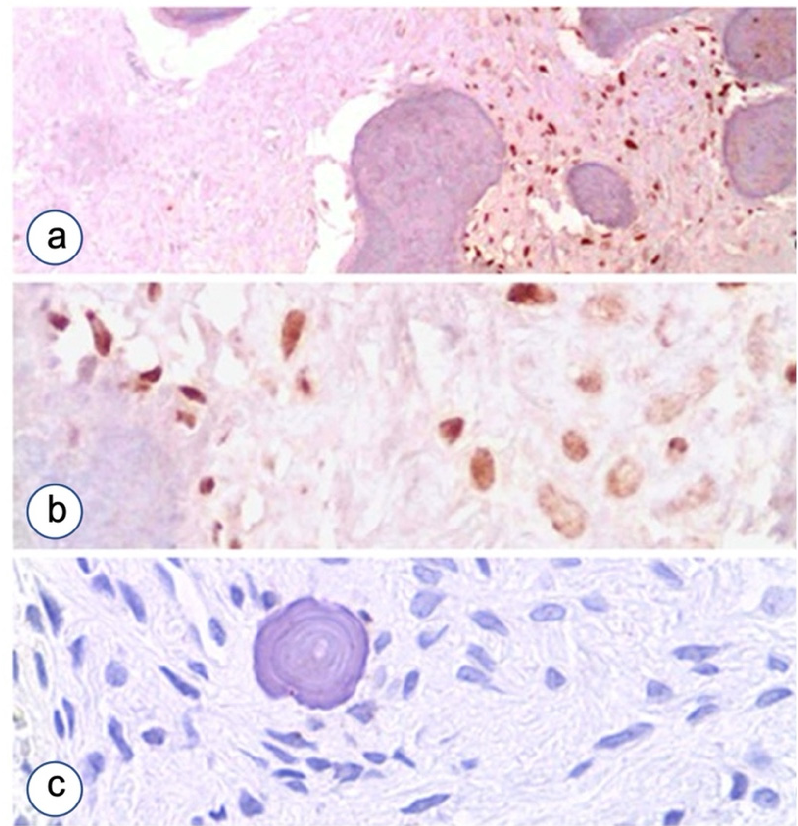
Figure 2. Cytokeratin cocktail in HPT-JT syndrome and fibrous dysplasia. CKAE1/AE3 is expressed in maxillary tumor associated with HPT-JT syndrome. ( a ), Further magnification in ( b ), but it stains negative in FD even in cases with high cellularity. ( c ) LSAB-HRP, nuclear counterstaining with hematoxylin. Magnifications, × 10 ( a ), × 40 ( b , c ).